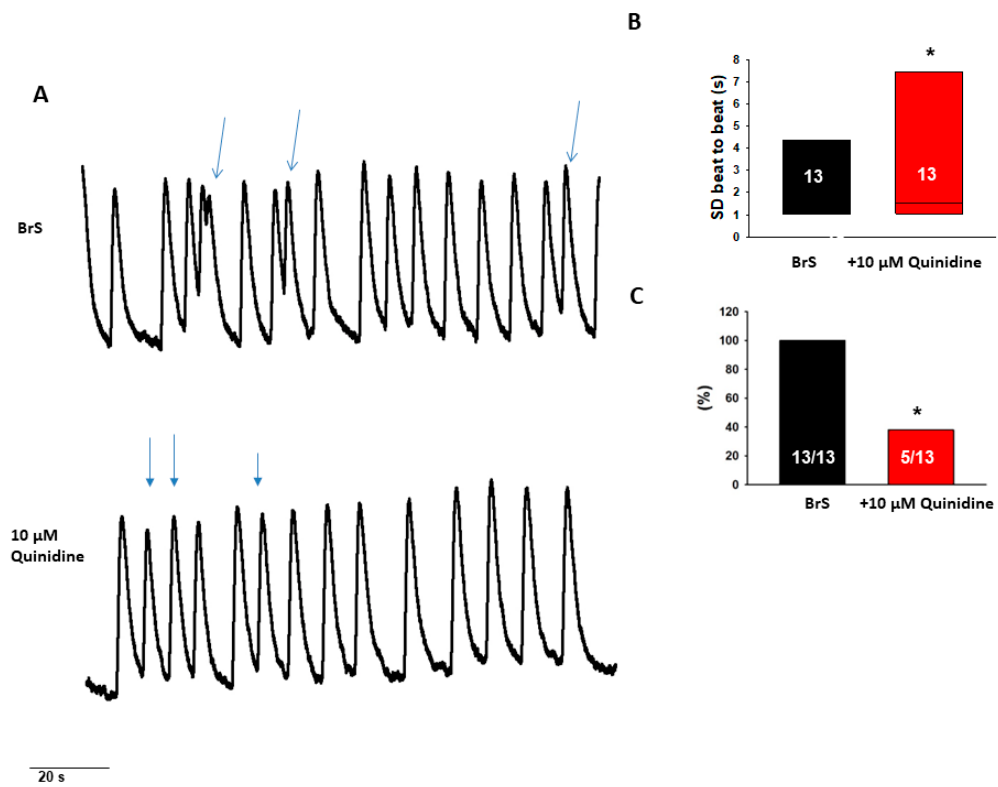
Figure 7. Effects of quinidine on the beating variability and arrhythmic events in BrS-hiPSC-CMs. ( A ) Representative traces of calcium transient before and after administration of 10 μ M quinidine in BrS-hiPSC-CMs. Only cells with arrhythmic events were used. ( B ) Median values of standard deviation (SD) of cell beating intervals. ( C ) Percentage of cells showing arrhythmic events. * p < 0.05 using Fisher’s exact test ( C ) or versus baseline according to t -test ( B ).